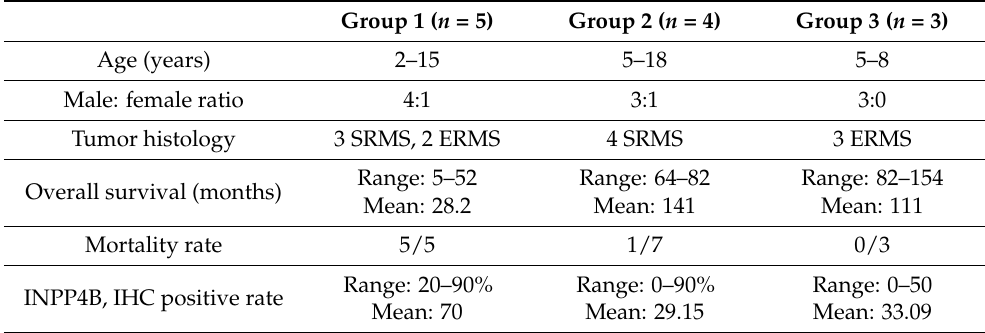
Table 1. Clinicopathologic features of RMS cases selected for NanoString digital